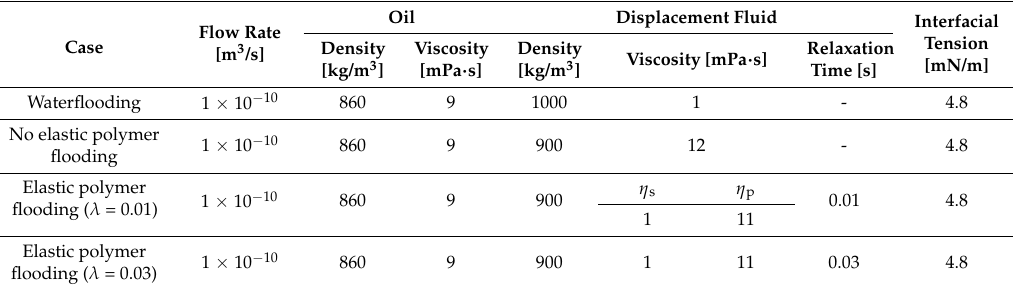
Table 1. Parameters of the four computational cases considered in this study.